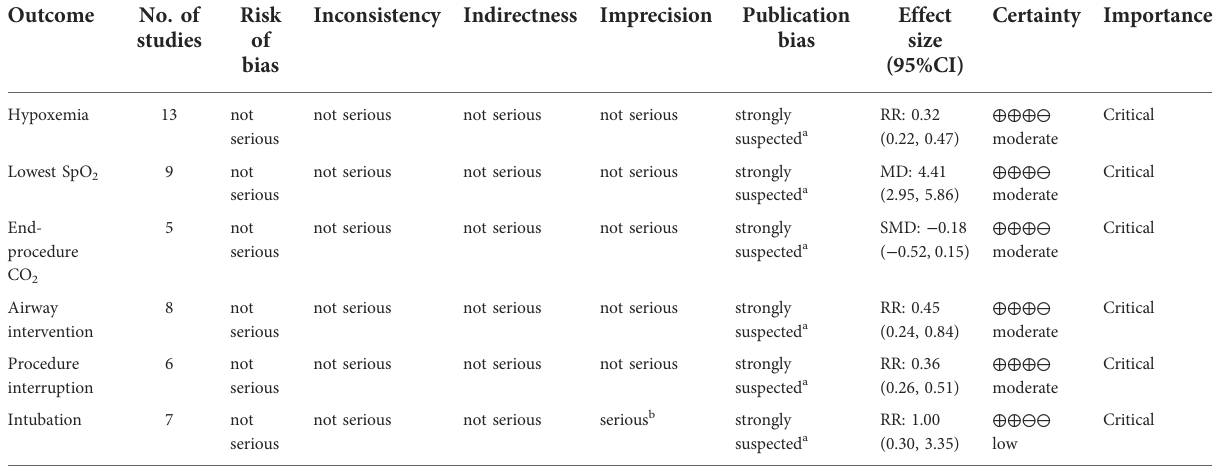
TABLE 2 GRADE evidence quality. Outcome No. of